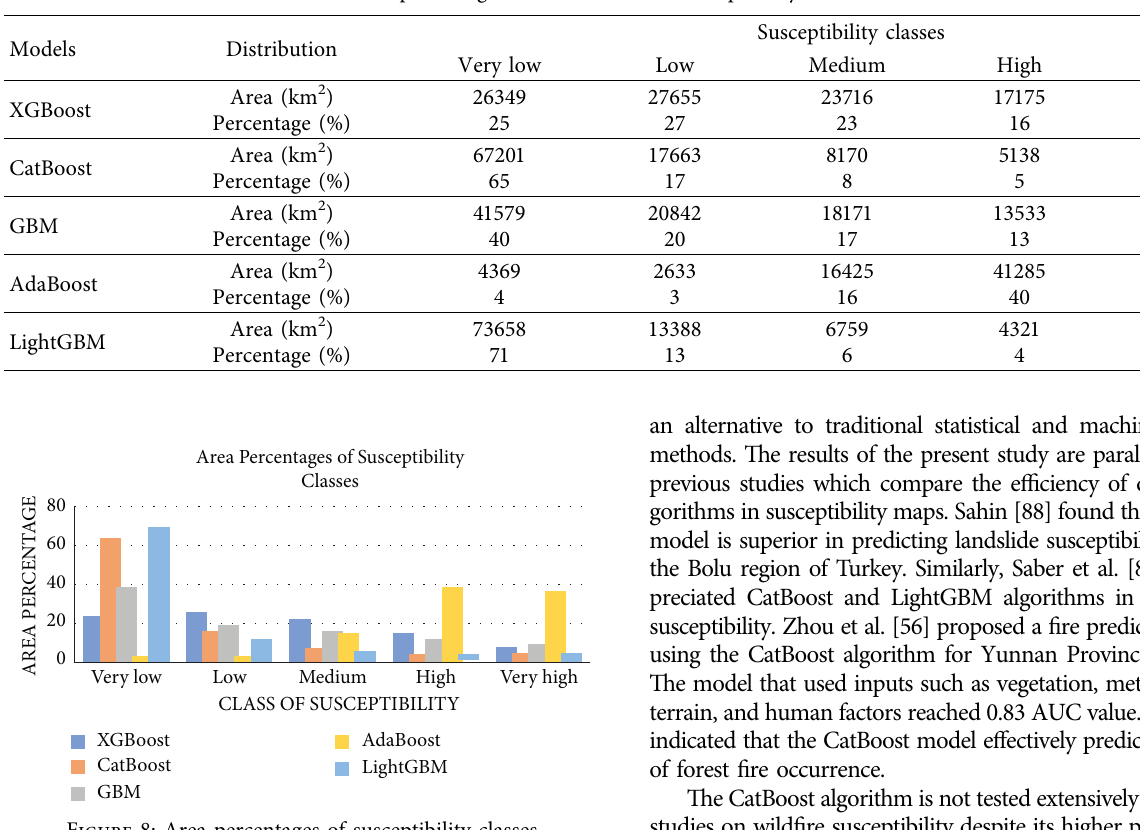
Table 4: Area and percentage distribution of the susceptibility classes of all the models.